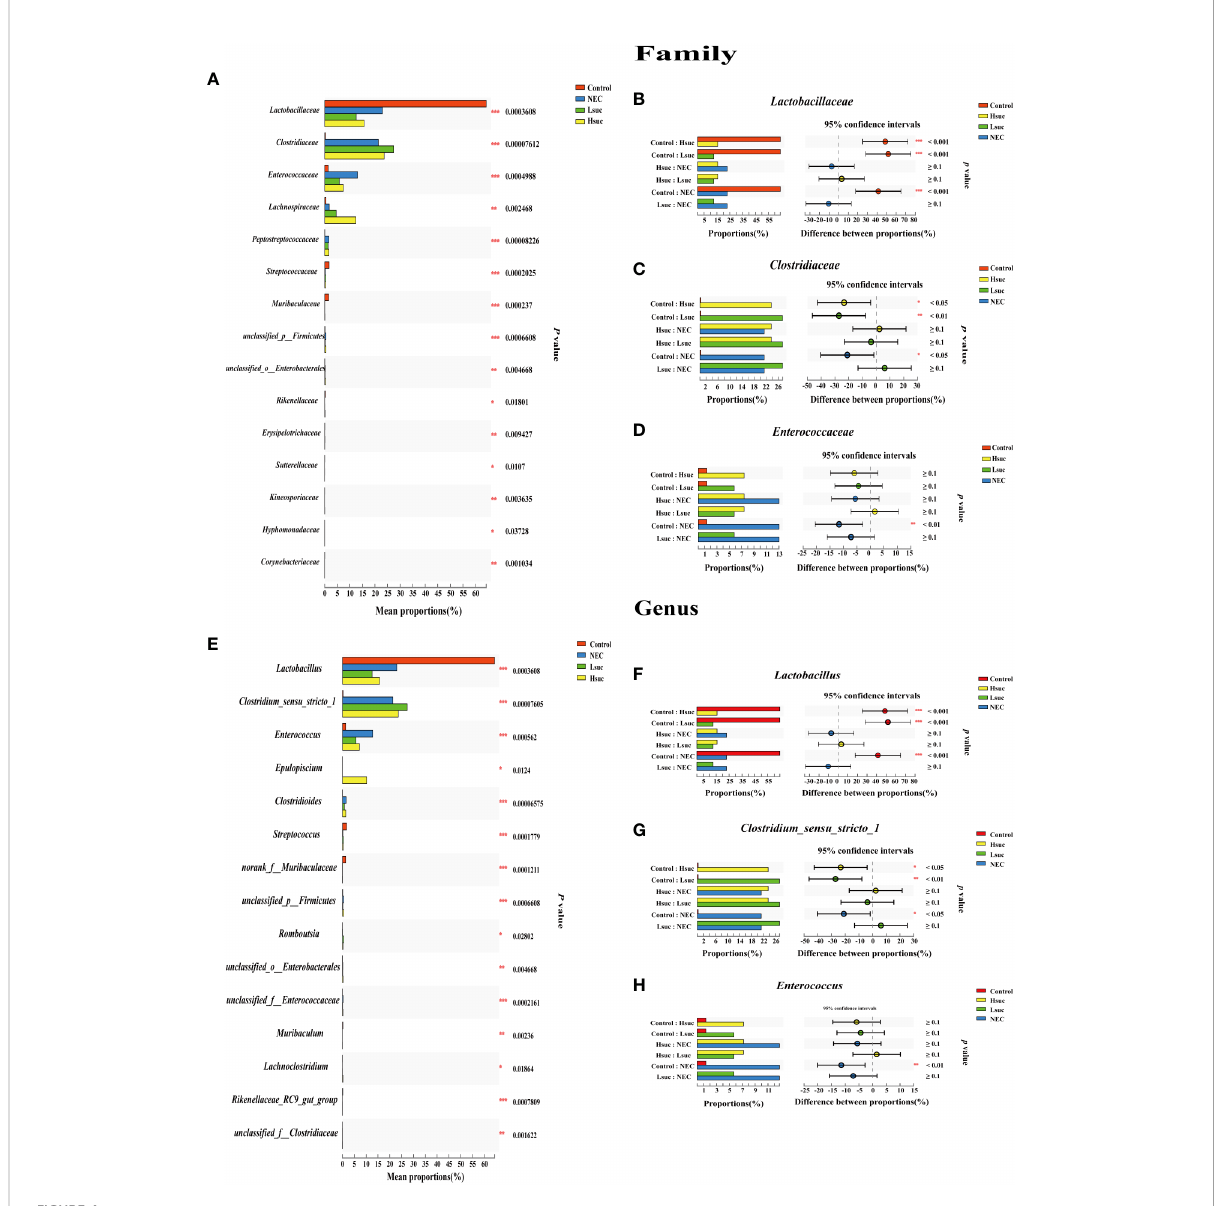
FIGURE 4 Comparisonof community abundance within fourindependent groups. Differences in fl ora composition among groupsof miceat the (A – D) family and (E – H) genus levels using the Kruskal – Wallis test with Dunn ’ s multiplecomparison post hoc test. Signi fi cant differences are shown by * P < 0.05, ** P < 0.01, *** P <